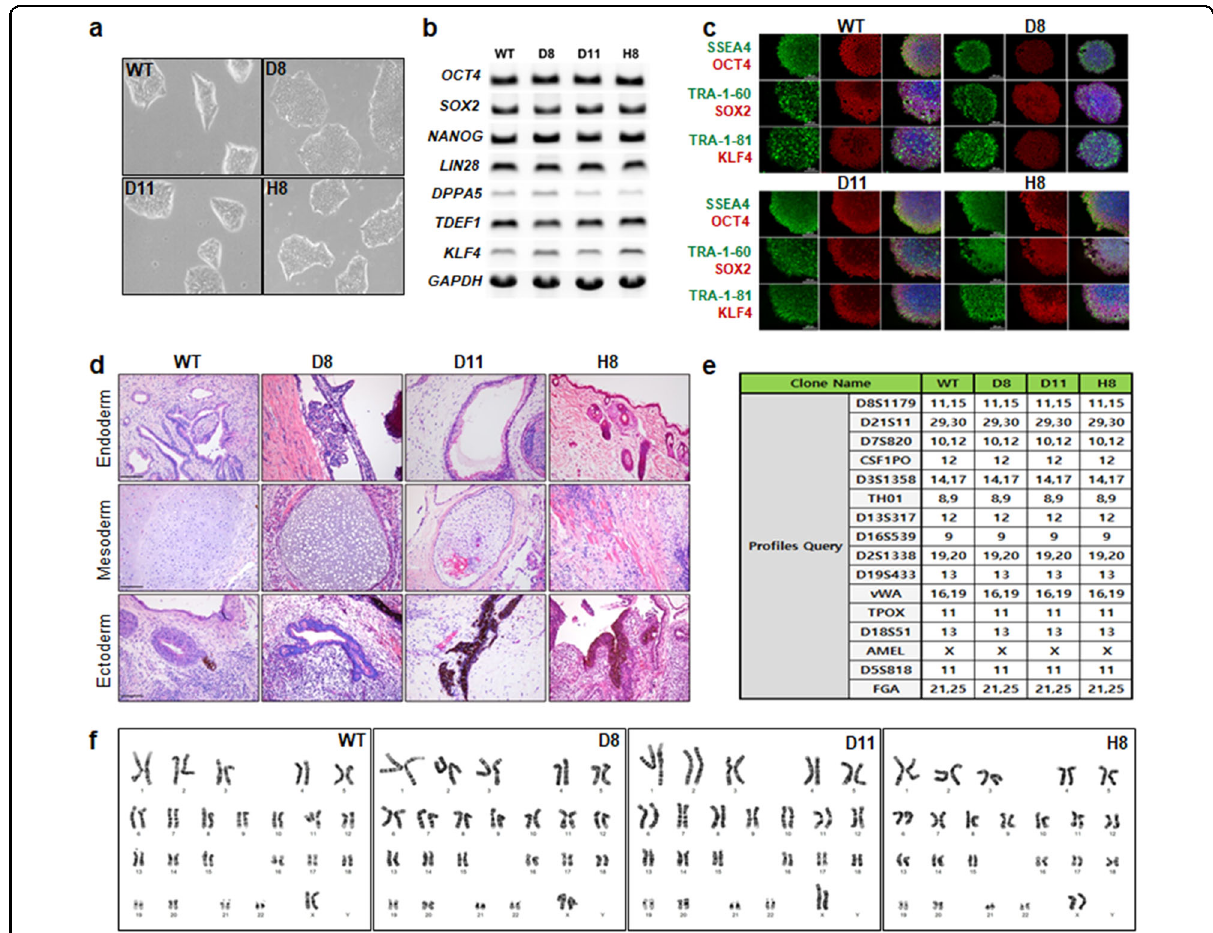
Fig. 3 Characterization of HLA-B – engineered iPSC clones. a Representative morphologies of HLA-B-engineered iPSC clones. Images were acquired on a Leica microscope (Leica Microsystems Ltd, EC3, image 40 × ). Expression analysis of stemness markers in the wild-type and HLA-B- engineered iPSC clones was performed at the b mRNA and c protein levels by RT-PCR and immuno fl uorescence staining, respectively (scale bar, 200 μ m). d Teratoma assay with wild-type and HLA-B-engineered iPSCs (scale bar, 200 μ m). e Genetic pro fi ling of wild-type and HLA-B-engineered